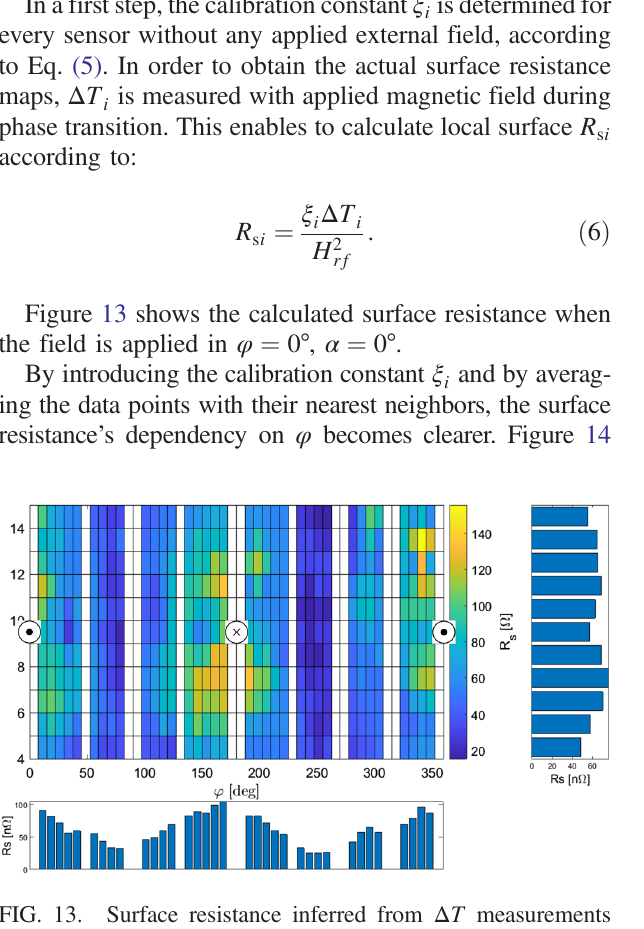
FIG. 13. Surface resistance inferred from Δ T measurements with applied field in φ ¼ 0 °, α ¼ 0